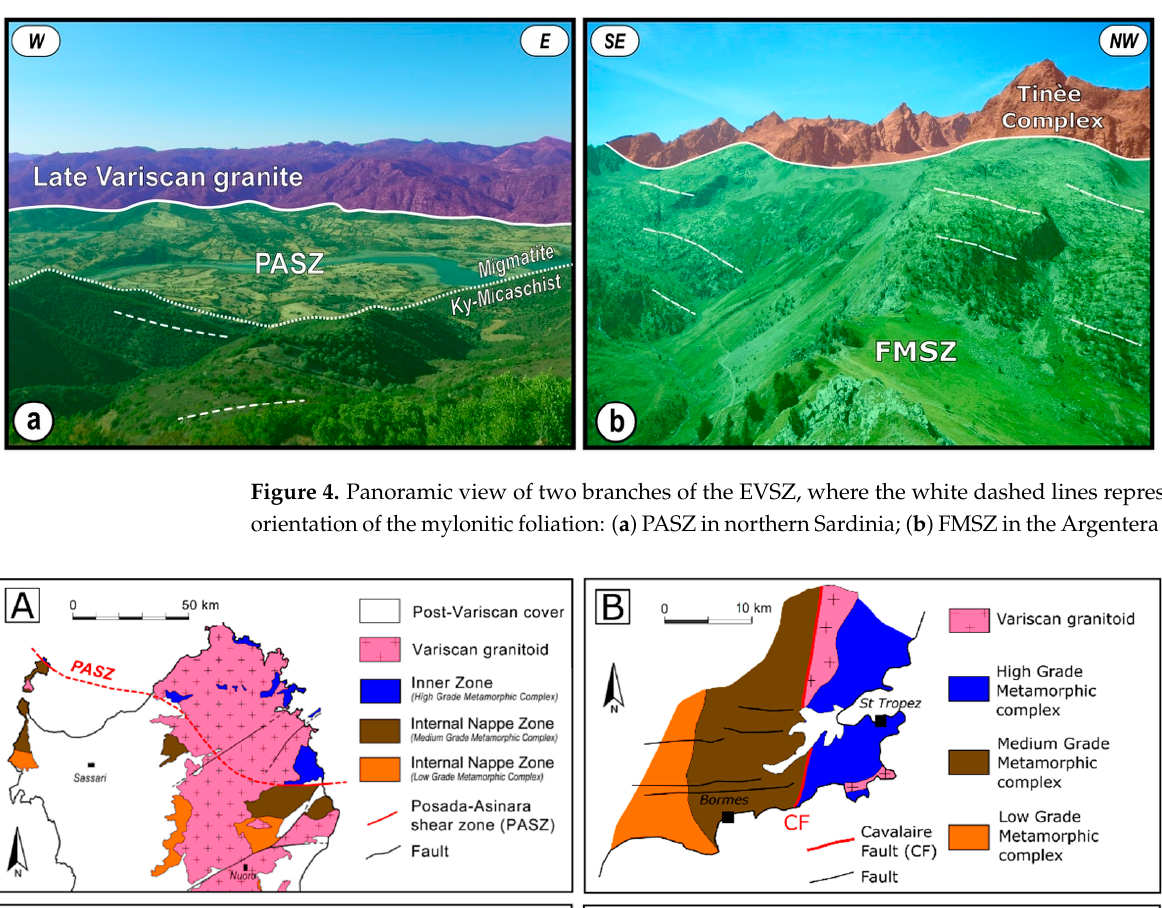
Geosciences 2022 , 12 , x FOR PEER REVIEW